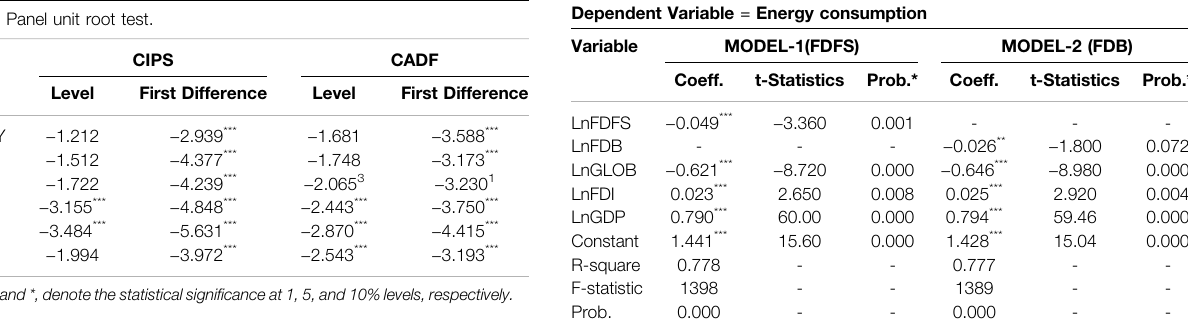
TABLE 5 | Results from panel DSUR